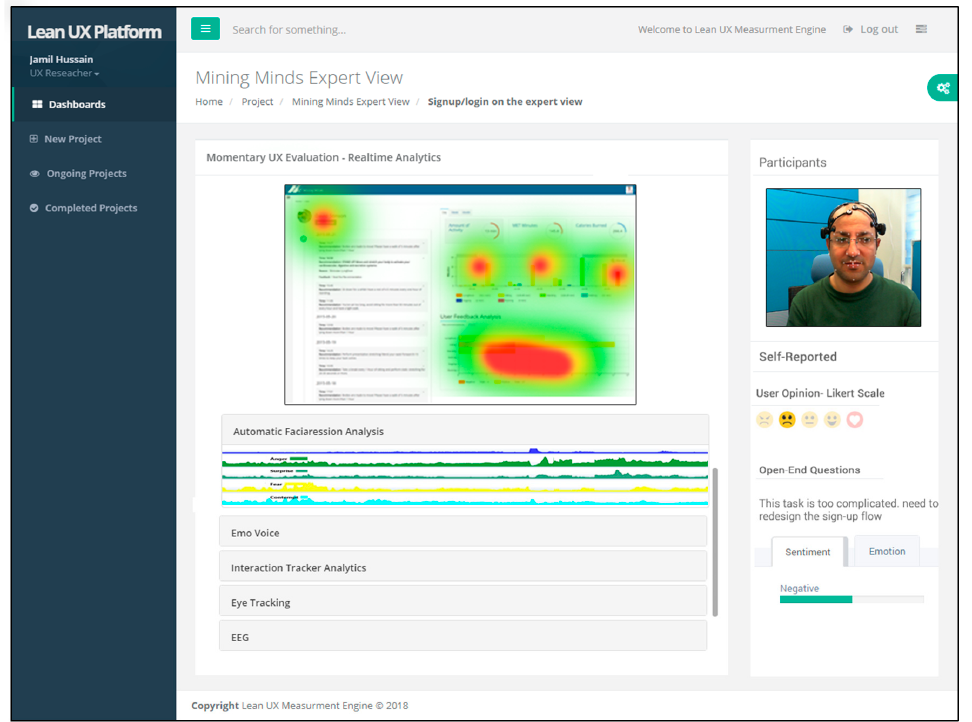
Figure 10. User Interface of UX toolkit.